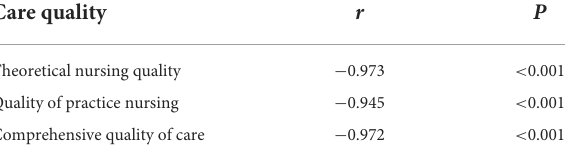
TABLE 6 Correlation between various scores of nursing quality and APACHE II score. Care